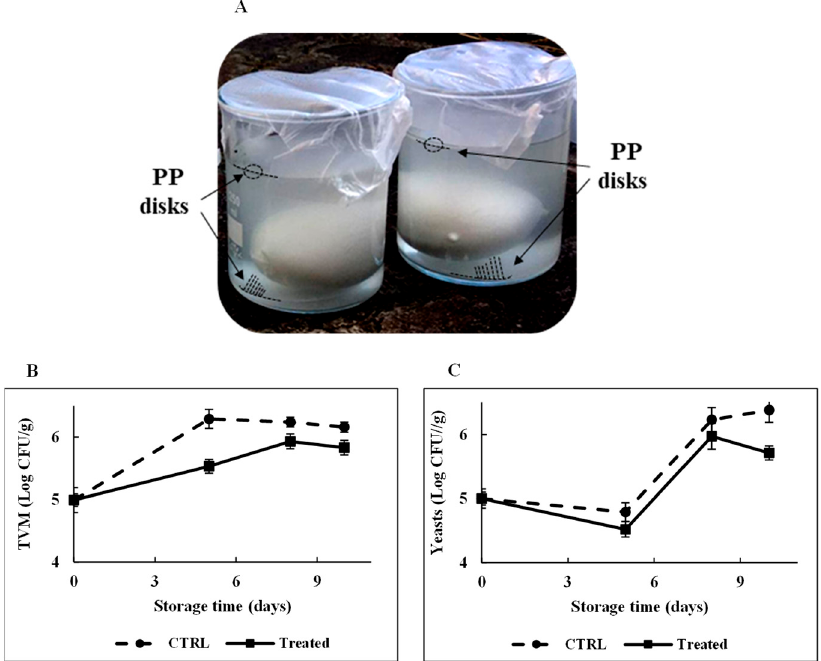
Figure 10. E ff ect of RiLK1-PPs on the microbiological quality of mozzarella cheese. ( A ) Photograph of preparation of mozzarella samples for the shelf life testing. A total of 50 g of fresh mozzarella cheese were immersed in 200 mL of brine in the presence of two functionalized PP disks placed above and below the food product. Not-functionalized PP disks were used as control. PP disks are indicated by the arrows. E ff ect of RiLK1-PPs treatment on ( B ) Total Viable Microorganism (TVM) and ( C ) yeast counts of mozzarella cheese samples during the storage time. CTRL: not-functionalized PP disks; treated: RiLK1-PP disks. Data are presented as means ± s.d. of five di ff erent samples analyzed in triplicate.